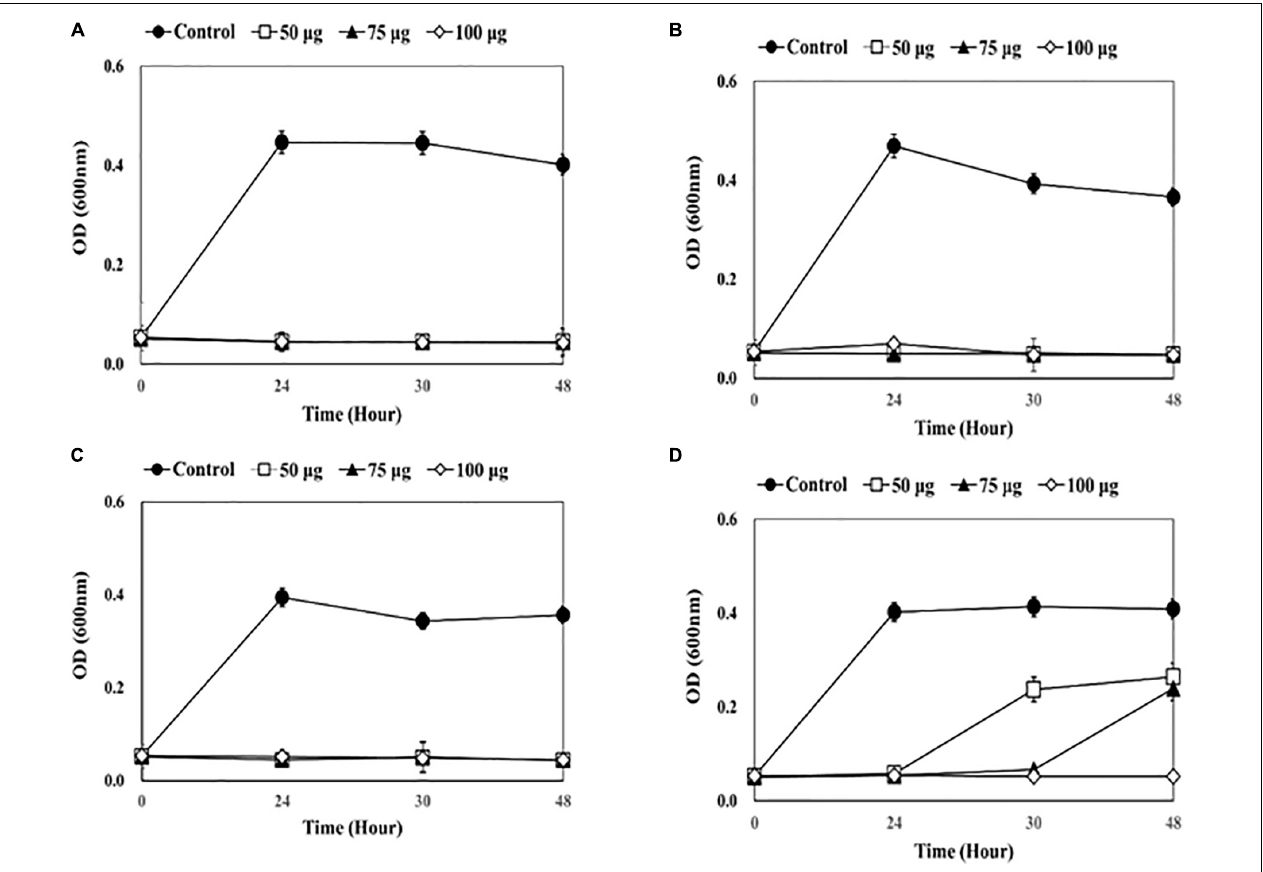
FIGURE 2 | Measuring optical density (OD) after adding endolysin CHAP-161 to catheter solution. (A) 1-5652, (B) 2-5652, (C) 3-5655, (D) 3-5652-A. These results were statistically evaluated and expressed with standard deviation error bars from three independent